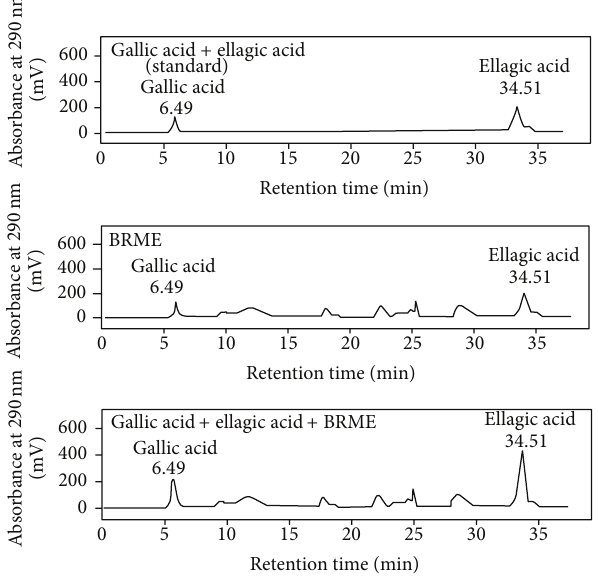
Figure 1: HPLC chromatogram of the standard gallic acid, ellagic acid, BRME, and mixture of standard + extract.